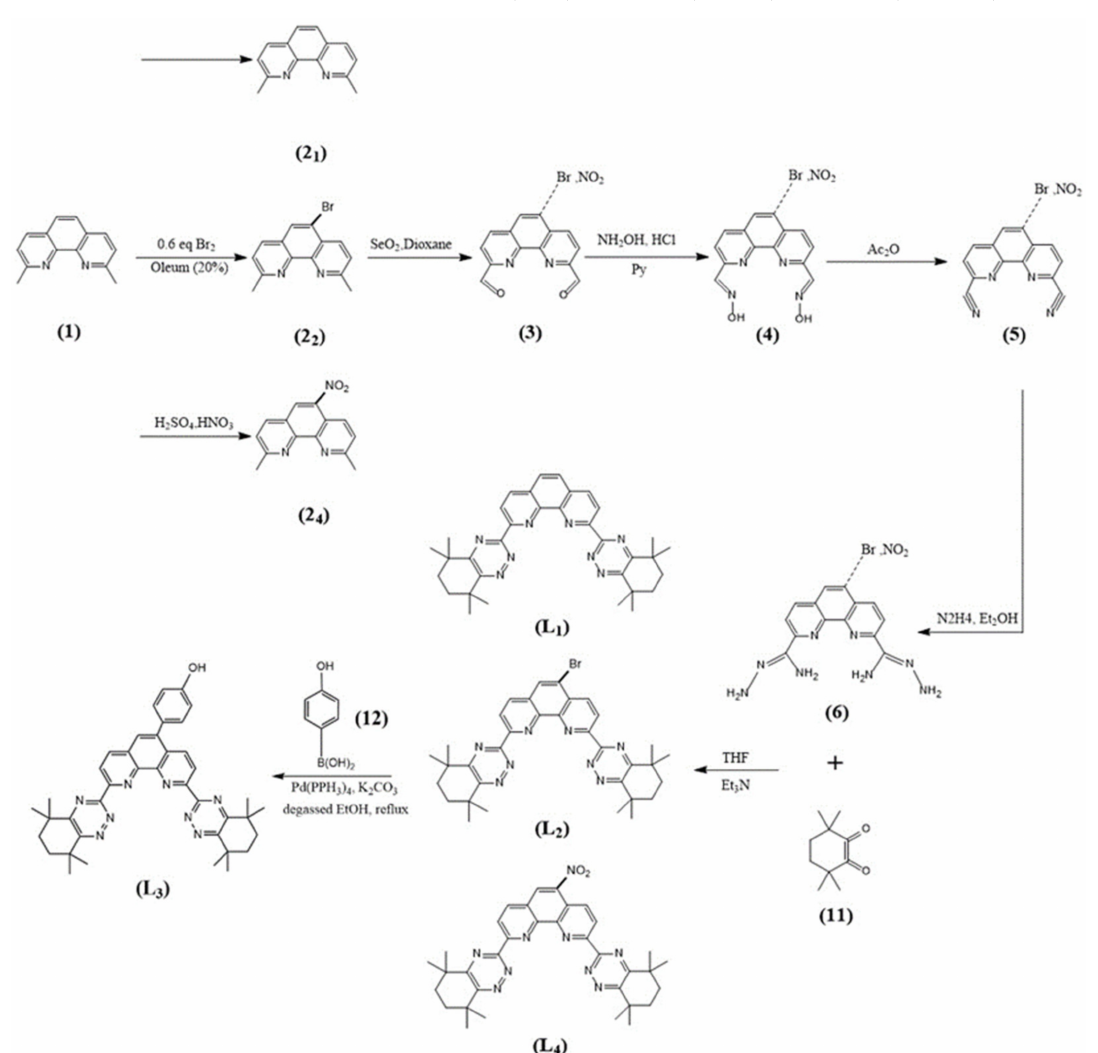
Figure 7. Syntheses of the BTPhen Ligand L1, L2, L3, and L4.